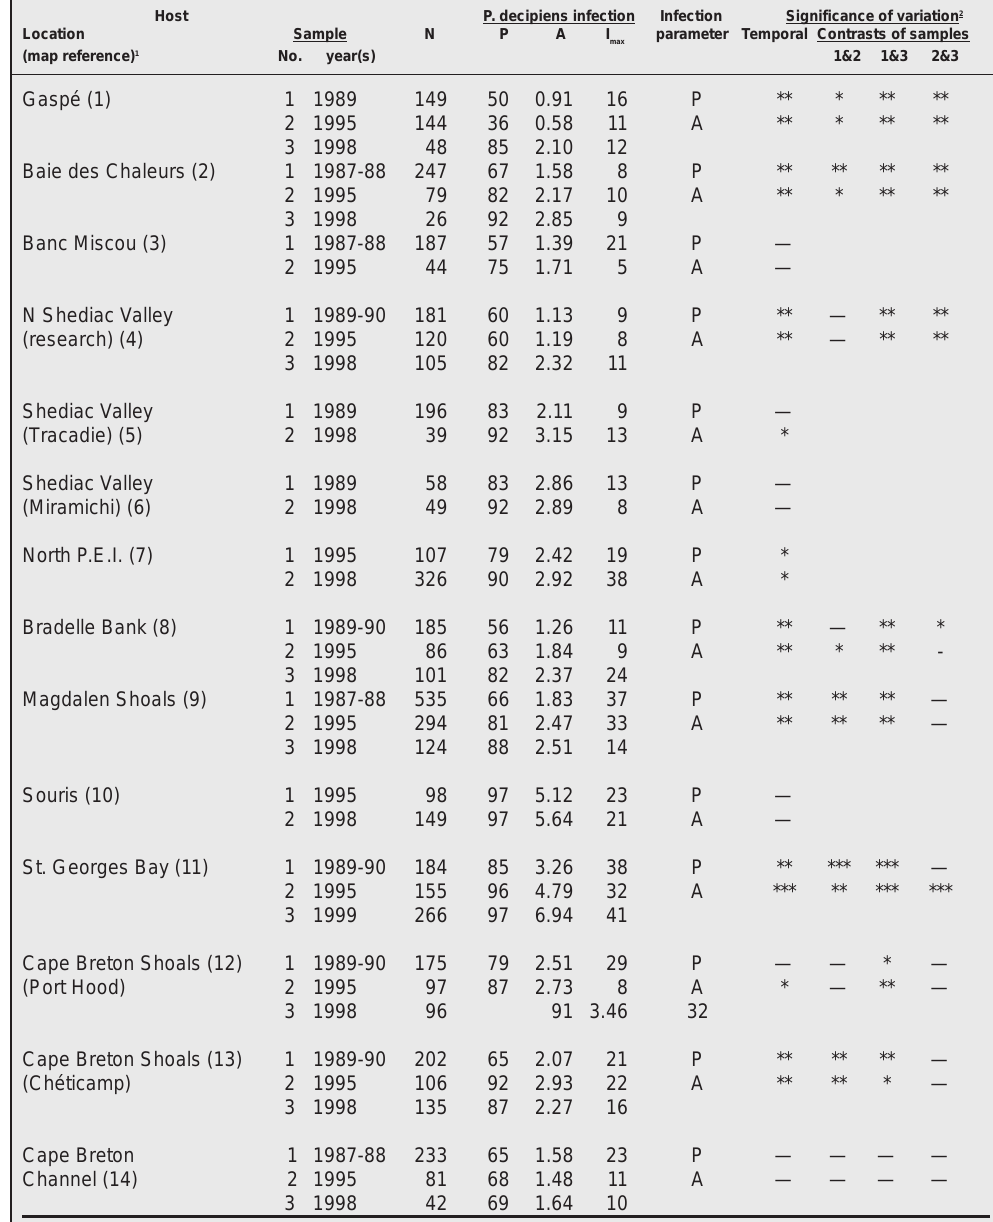
Table 1. Prevalence (P), abundance (A) and maximum intensity (I infection in Hippoglossoides platessoides , 31-40 cm in length, from the southern Gulf of St. Lawrence, with temporal contrasts of prevalence and